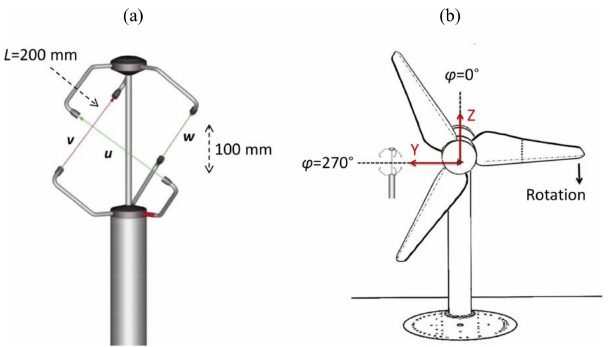
Figure 5. (a) Ultrasonic anemometer, with permission from Thies CLIMA. (b) Definition of the azimuthal blade positions looking